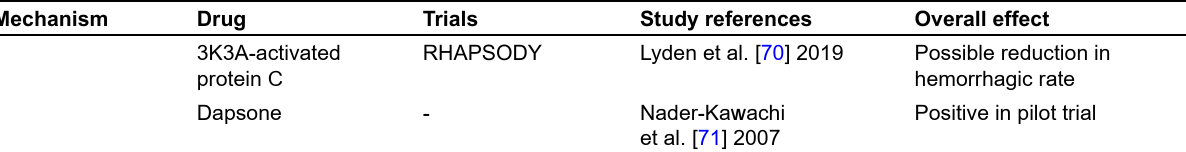
Table 1. Overview of human trials on neuroprotective agents in AIS ( continued )